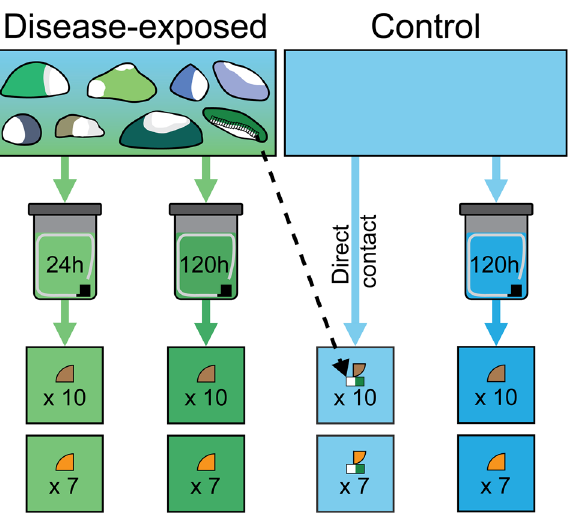
Figure 2. Ballast water experiment infographic. Disease water generation using field-collected colonies of Montastraea cavernosa exhibiting SCTLD lesions (top), subsequent ballasting in sealed 208 L (55 gal) containers (middle), and exposure of water treatments to fragments of Orbicella faveolata (brown) and Pseudodiploria strigosa (orange) in 150 L aquaria via daily water changes over seven days